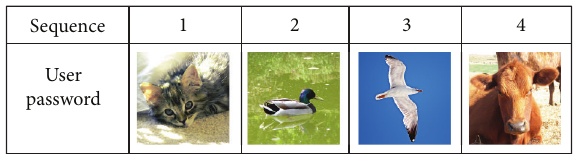
Figure 1: An example of user password pictures and its sequence.